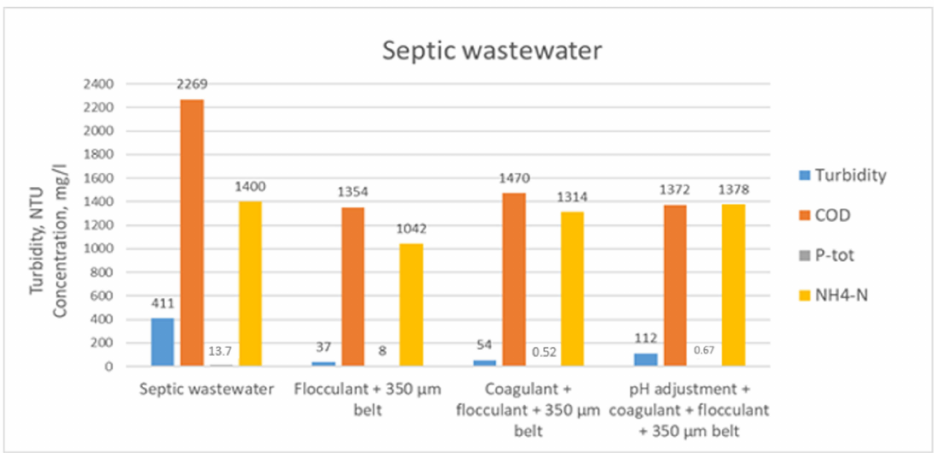
Figure 6. Turbidity rejection and reduction in COD, P-tot, and NH 4 -N in chemical treatments and belt filtration of septic wastewater at laboratory scale tests.